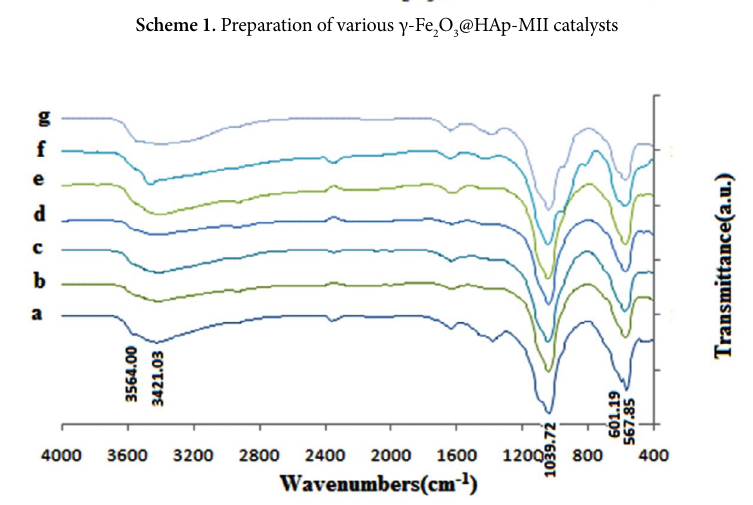
Fig. 1. FT-IR spectra of γ-Fe